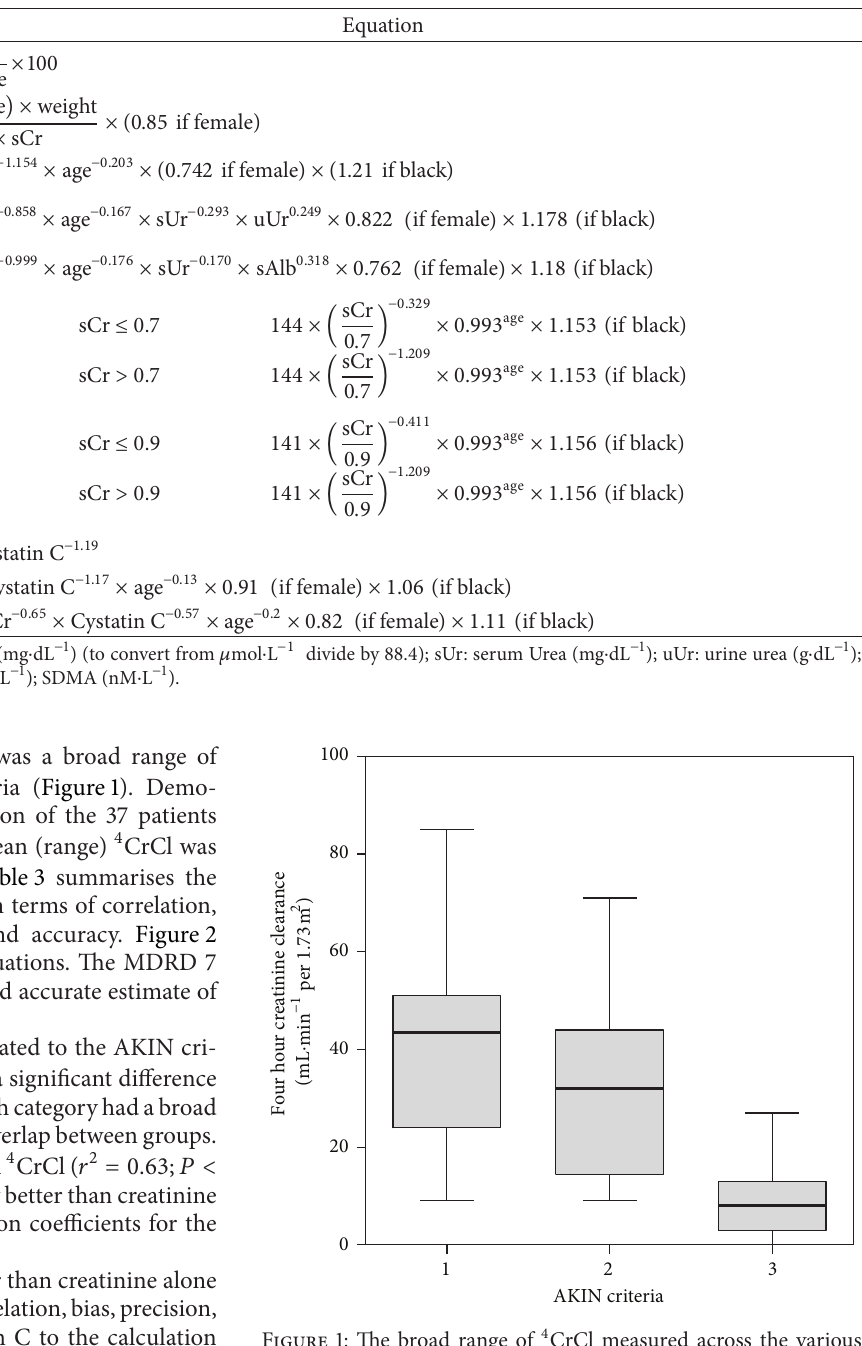
Figure 1: The broad range of 4 CrCl measured across the various AKIN criteria in 51 critically ill patients with AKIN defined